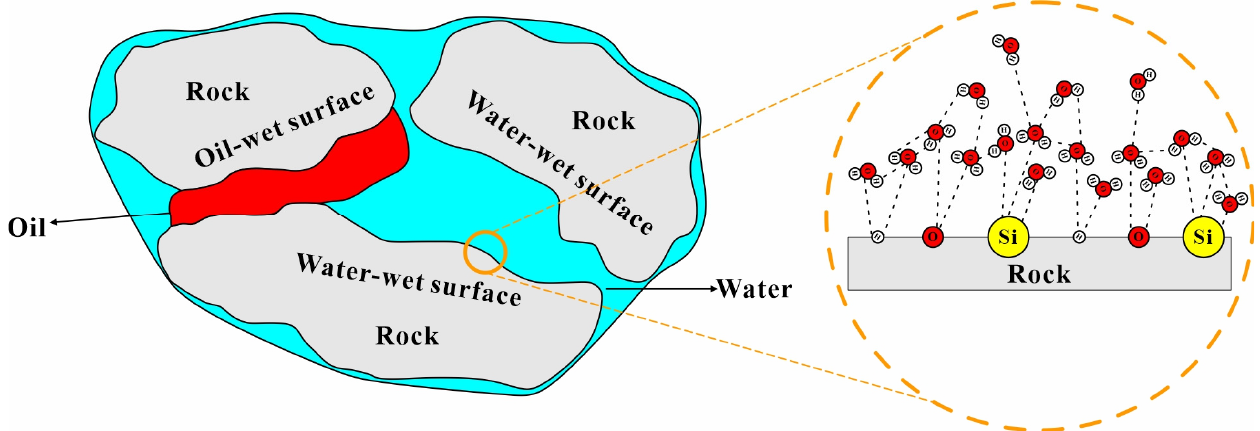
Figure 10. Adsorption of water on the water-wet surface of the rock.